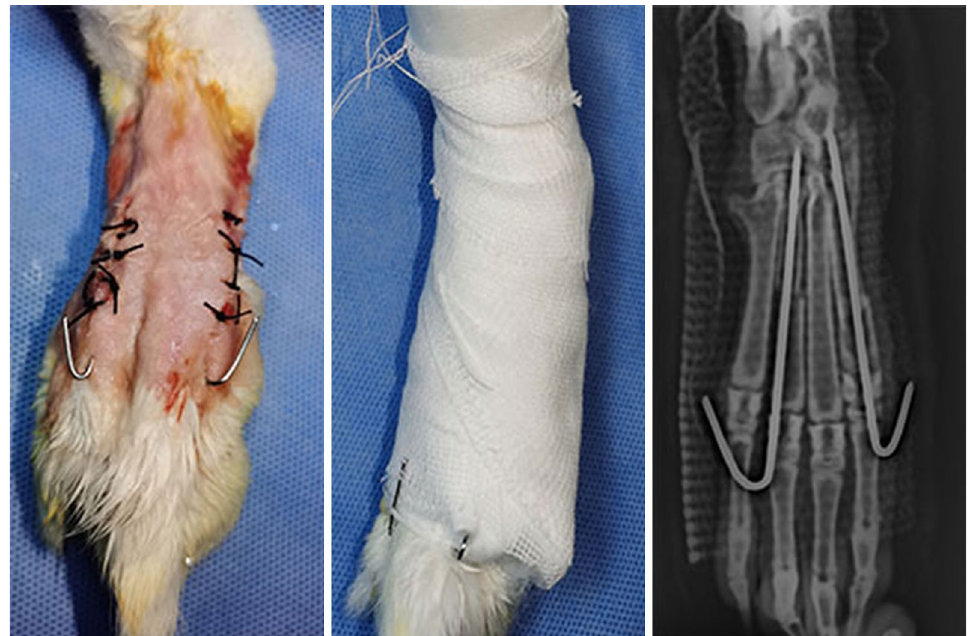
Figure 2. Double-fracture model of the toe bone of the New Zealand great white